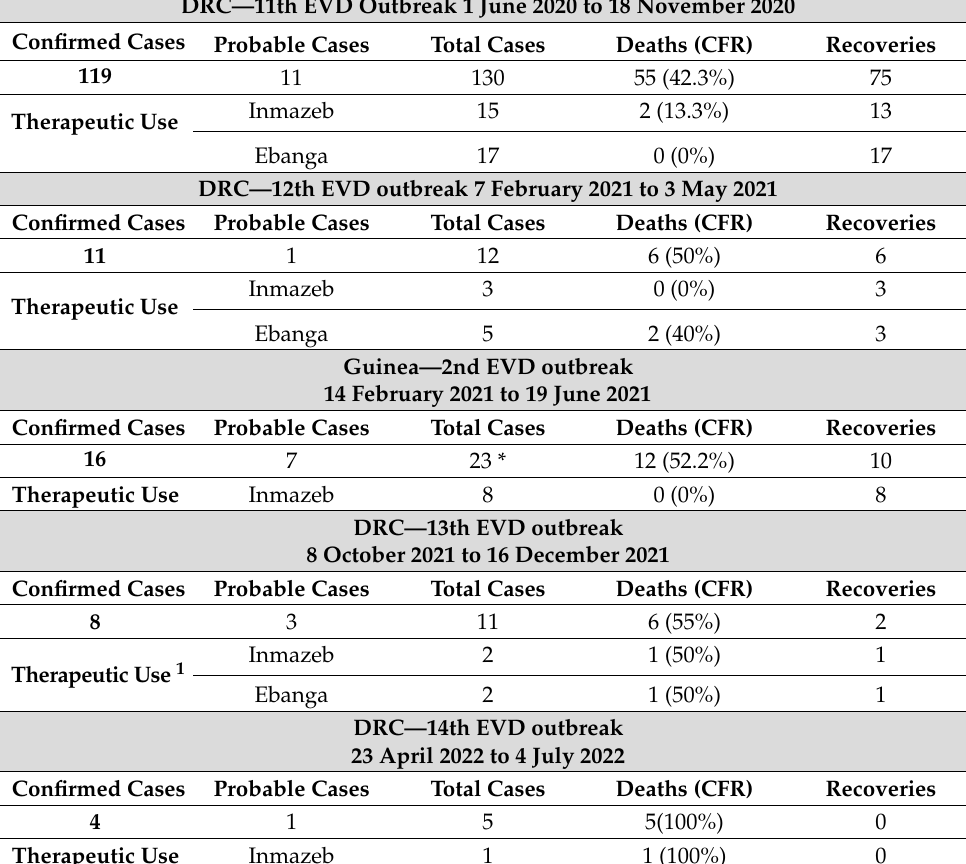
Table 1. Summary of recent Zaire ebolavirus (EBOV) outbreaks and therapeutic use [Case fatality rate